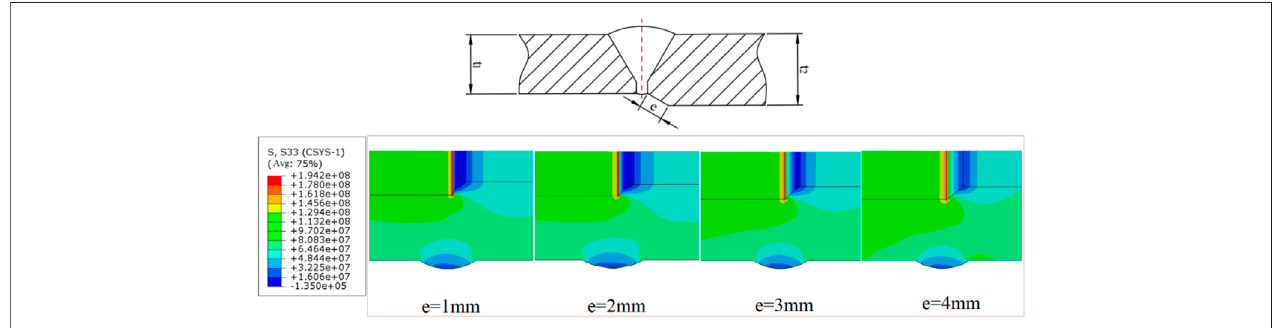
FIGURE 13 | Stress nephogram in fl uenced by weld conical surface length.